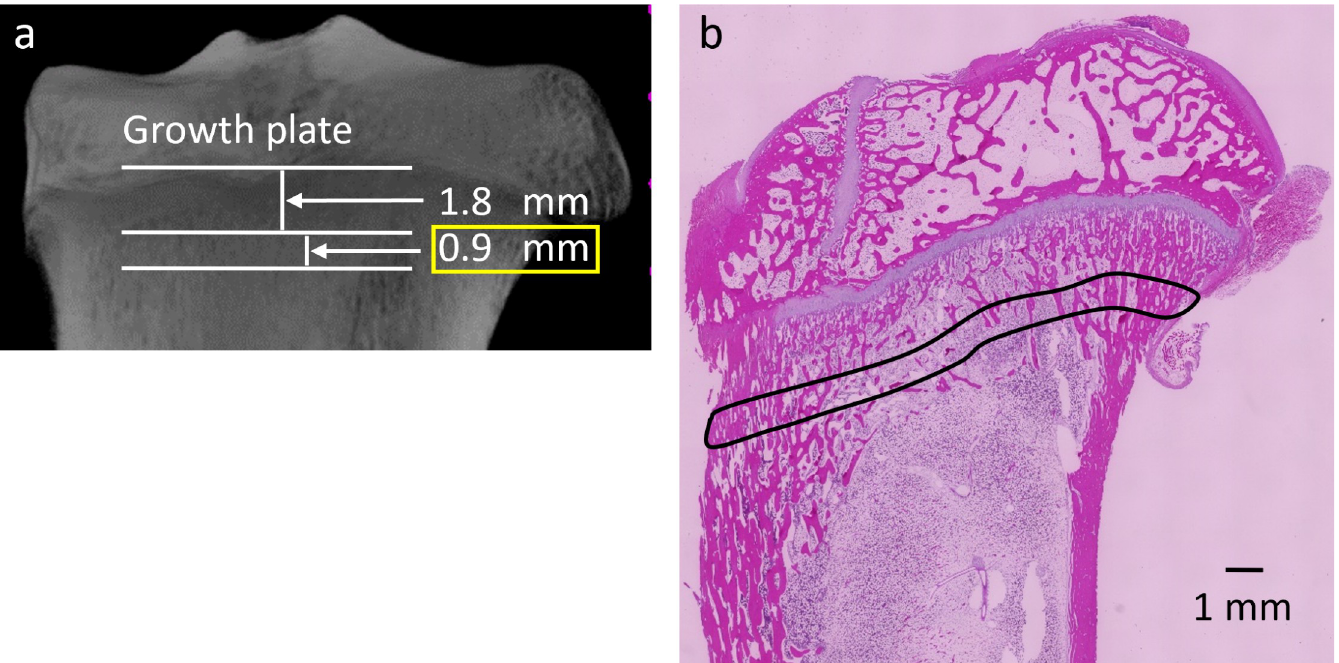
Fig 2. ROI. The region of interest (ROI) was from a slice 1.8 mm below the growth plate to the 100th distal slice. (a) ROI of micro-computed tomography analysis and (b) measurement area of histological evaluation.